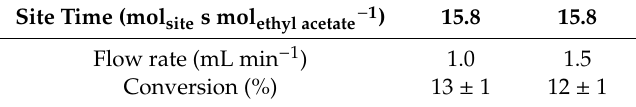
Table 2. Conversion and flow rate for two transesterification experiments with an identical site time.